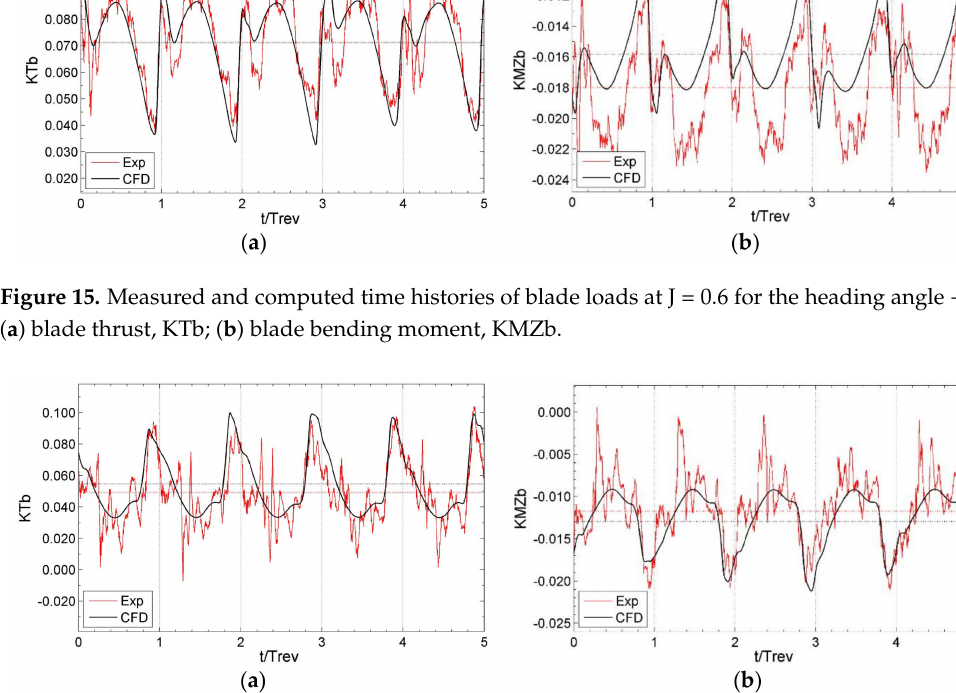
Figure 16. Measured and computed time histories of blade loads at J = 0.6 for the heading angle − 35 ◦